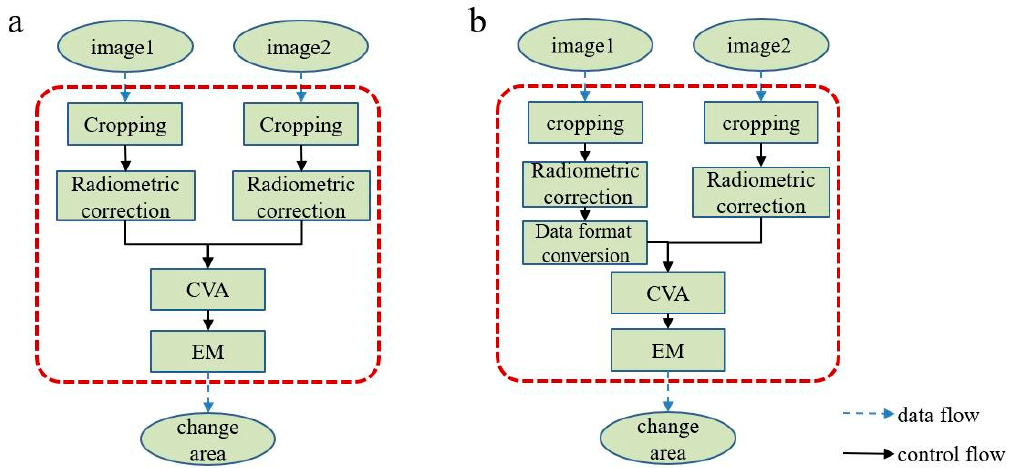
Figure 11. Two generated change detection service chains: (a) service chain based on the traditional method; (b) service chain based on the proposed method.